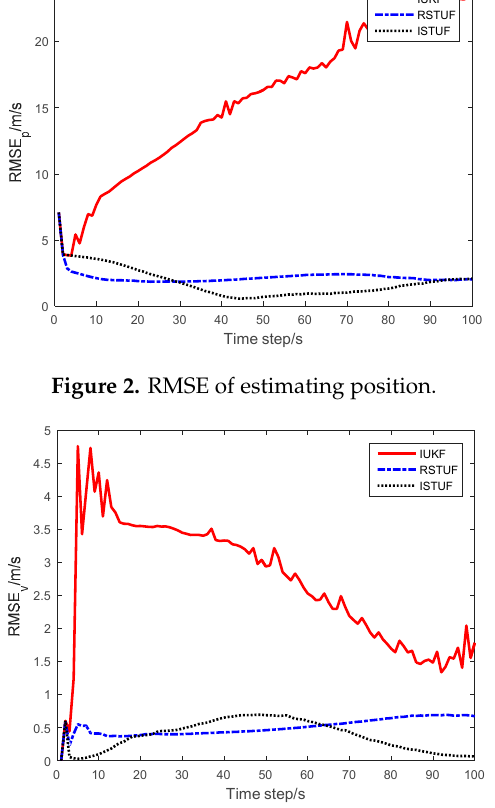
Figure 3. RMSE of estimating velocity.